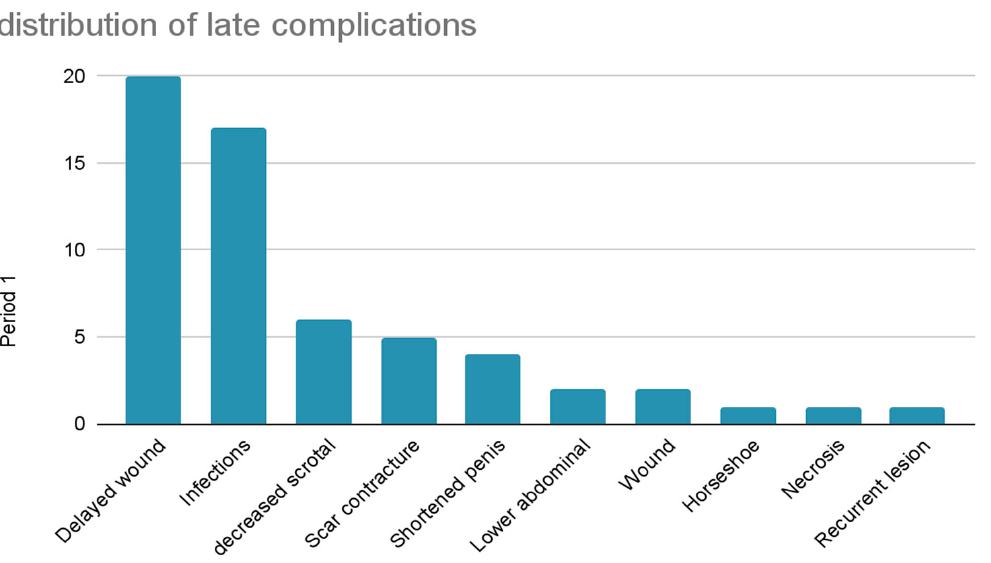
Figure 11. Distribution of late complications.